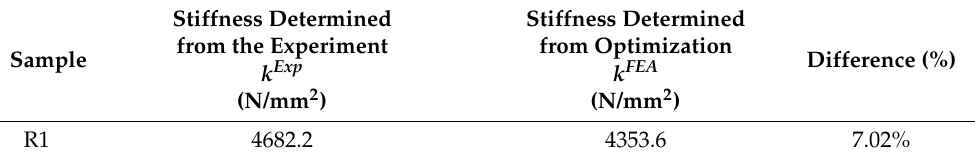
Figure 16. Comparison of the stiffness obtained from the experiment and the numerical analysis for the R1 sample based on the data obtained from the optimization. Table 10. Comparison of stiffness for sample